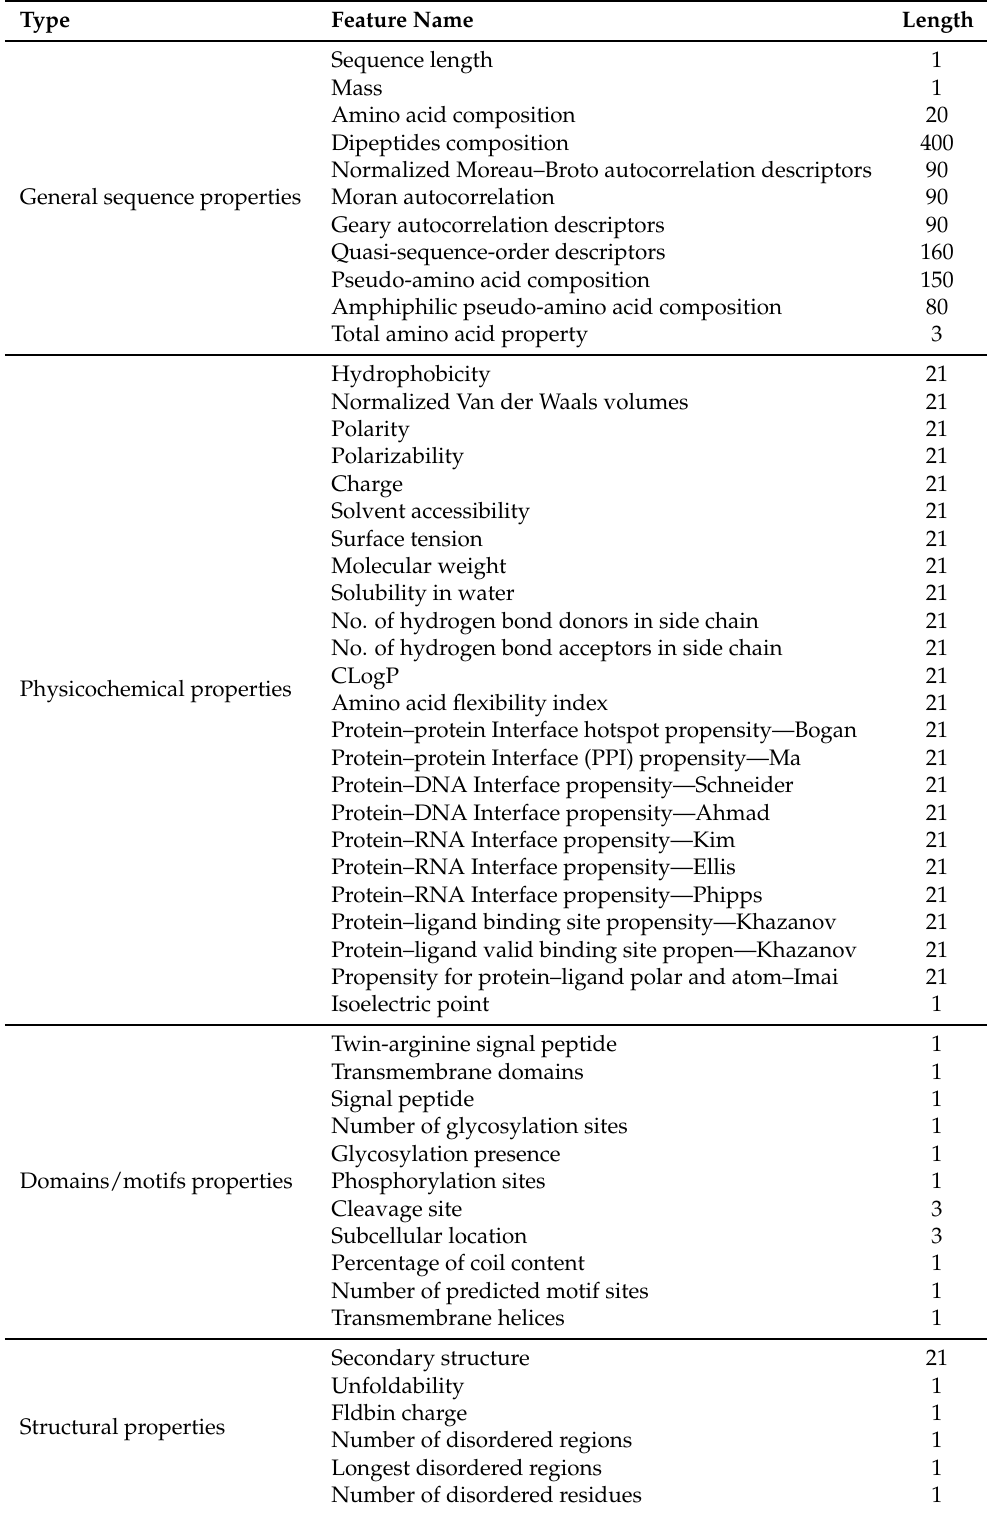
Table 3. The four types of features collected for the prediction of CSF